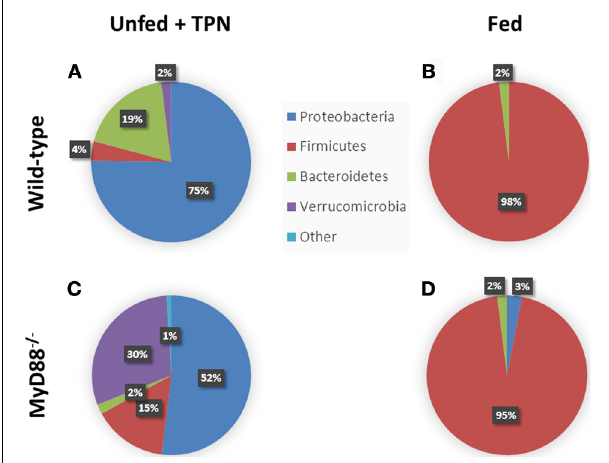
FIGURE 3 | Phylum-level changes in intestinal microbiota with TPN. Enteric bacteria from TPN-dependent mice (A) demonstrate a relative increase in Proteobacteria and Bacteroidetes vs. fed mice (B) , where Firmicutes dominates. MyD88 − / − mice, with defective TLR signaling, demonstrate an additional expansion of Verrucomicrobia with TPN-dependence (C) vs. fed controls (D) . Akkermansia species predominate among the Verrucomicrobia. Adapted from Miyasaka et al.